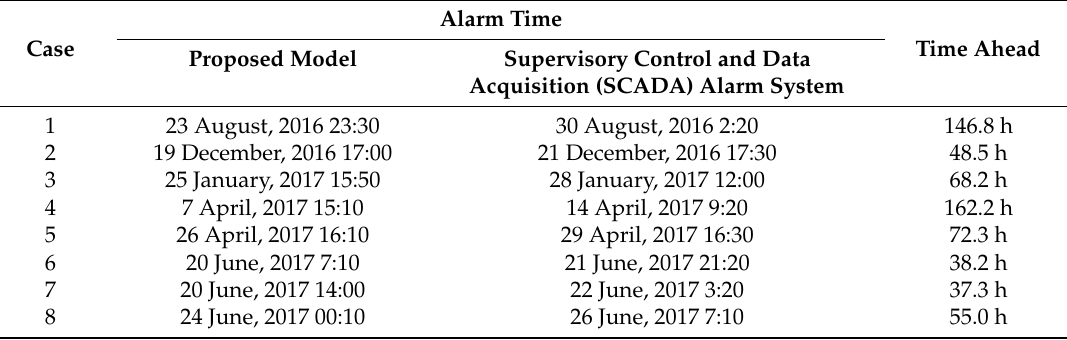
Table 7. The monitoring results of pitch-system failure